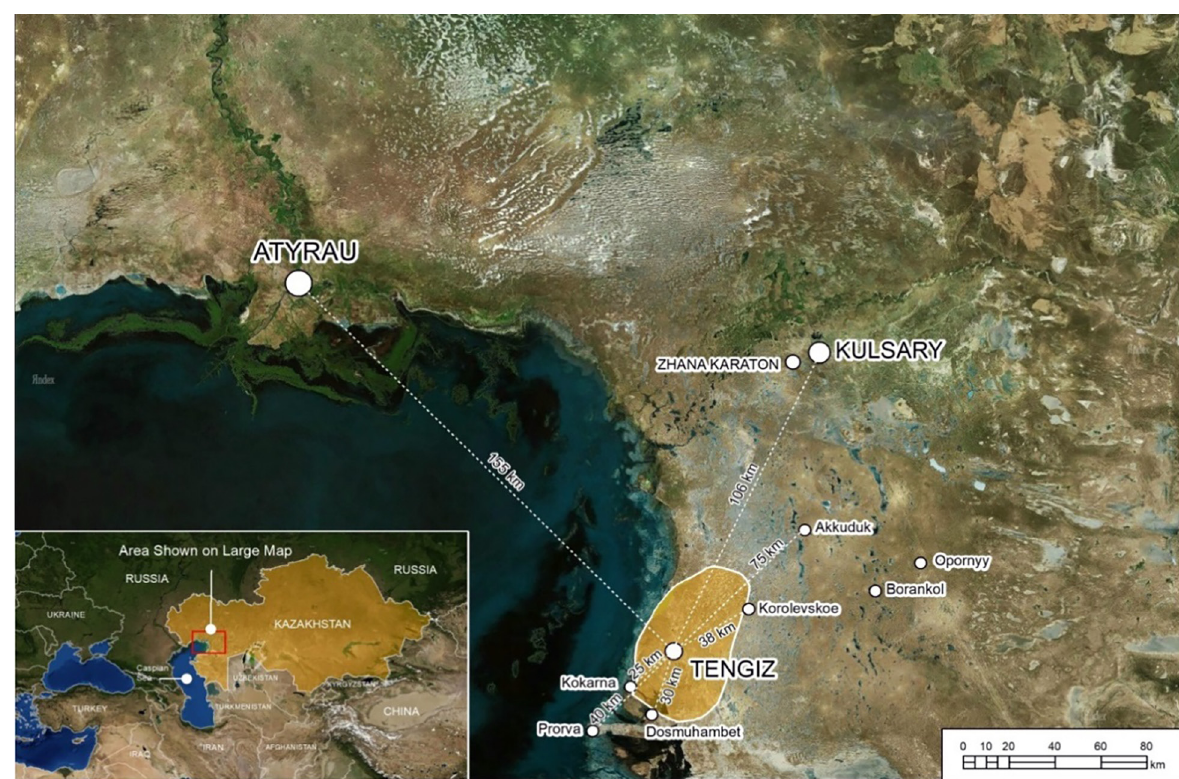
Fig. 2. An overview map of the study area (Tengiz oil field). Source: own